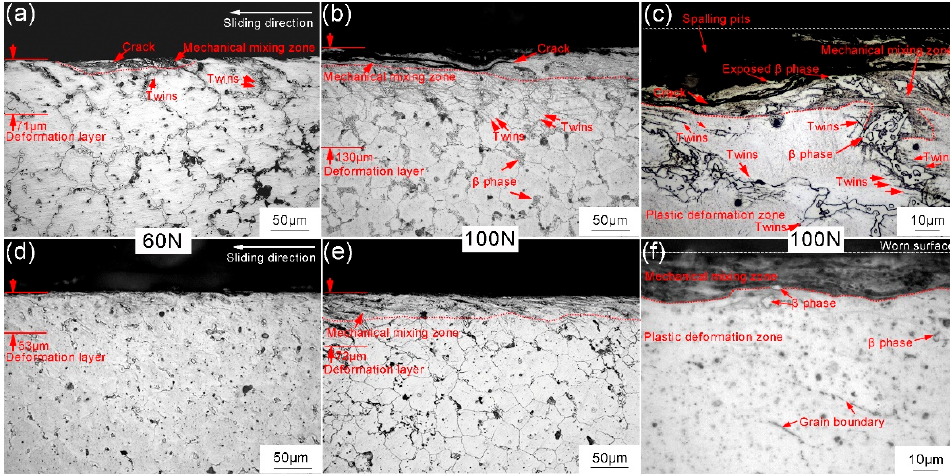
Figure 10. Microstructure of subsurface layers of surfacing magnesium alloys after friction and wear: ( a – c ) AZ91 alloy, ( d – f ) AZ91 + 0.5 Gd alloy.